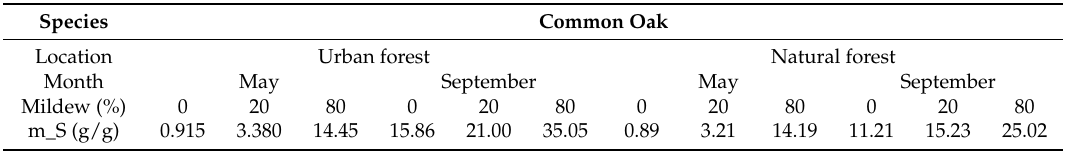
Table 1. Variability in the water storage capacity of common oak.